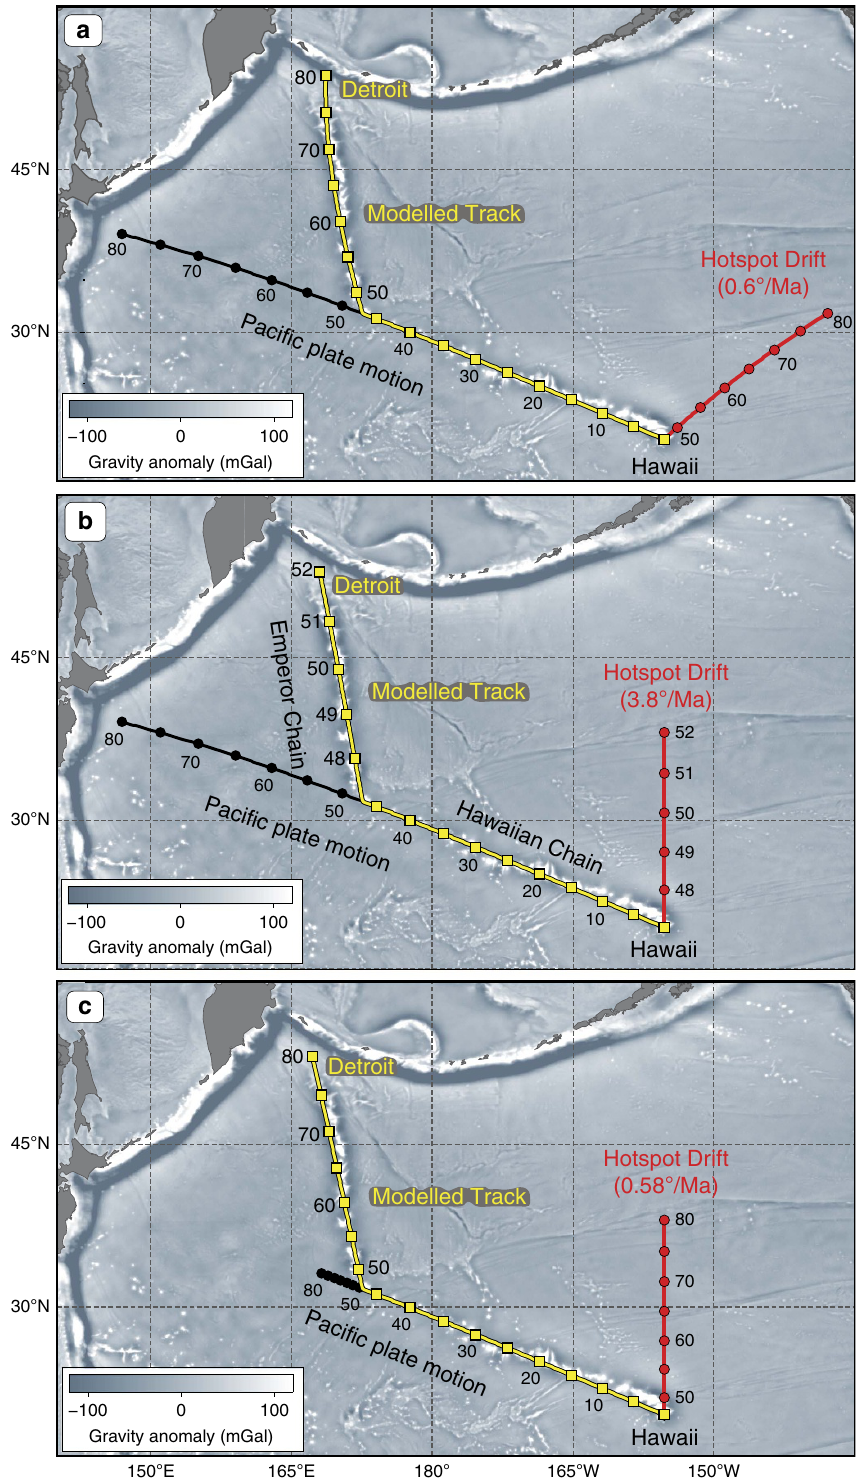
Figure 3 | Simulating the Hawaiian-Emperor Bend. ( a ) A simulation that assumes that the Pacific plate moves with a constant angular velocity to the north-west ( o ¼ 0.72 (cid:2) /Ma, Euler pole: 68 (cid:2) S, 103 (cid:2) E, see text), which requires south-westward hotspot motion (by 20.1 (cid:2) about the Euler pole at 44.3 (cid:2) S, 274.6 (cid:2) E, B 0.6 (cid:2) /Ma) in order to form the Emperor Seamounts during the 80–47Ma period and reproduce the geometry of the Hawaiian-Emperor Chain. ( b ) To produce a 60 (cid:2) bend with the Pacific plate not changing its direction and velocity (same as in plate a) and purely southward hotspot drift ( B 19 (cid:2) of motion corresponding to the north-south extent of the chain) requires an extreme rate of hotspot motion (3.8 (cid:2) /Ma), which would imply that the Emperor Chain has been created in just 5Myrs and Detroit Seamount is only 52Myrs old. ( c ) To form the Emperor Chain over the 80–47Ma period with the southward hotspot drift of B 19 (cid:2) of motion, ( B 0.58 (cid:2) /Ma) and no change in the direction of plate motion we must assume that the Pacific plate has moved at an extremely slow rate before 47Ma (0.13 (cid:2) /Myr), which was followed by a nearly sixfold velocity increase after the formation of the bend (to 0.72 (cid:2)